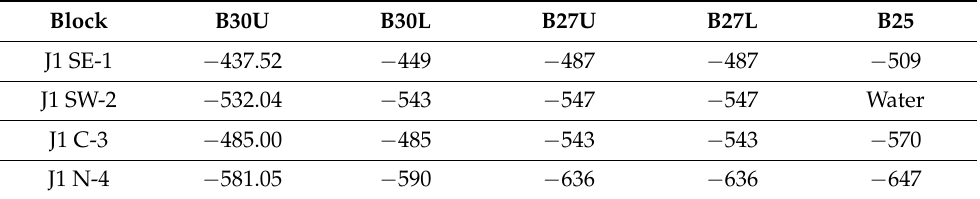
Table 2. Depths of water–oil contact (m) for the J1 Oil Field.